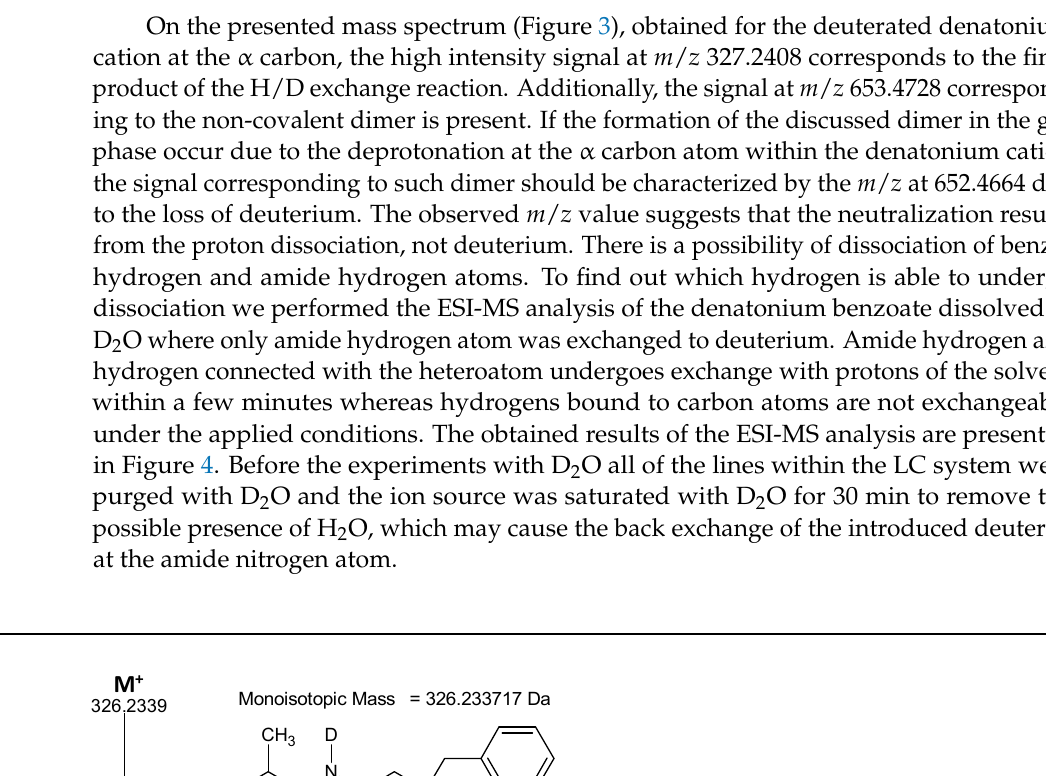
Figure 3. ESI-MS/MS spectrum of denatonium cation after hydrogen-deuterium exchange at the α carbon atom in the positive ion mode. m / z range from 50 to 1000.